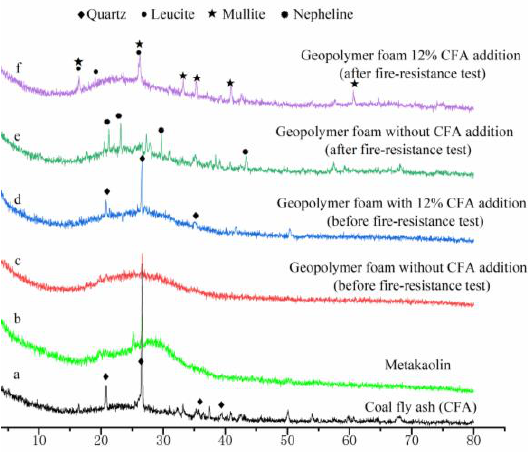
Figure 6. XRD patterns of the raw material and selected geopolymer foam specimens.